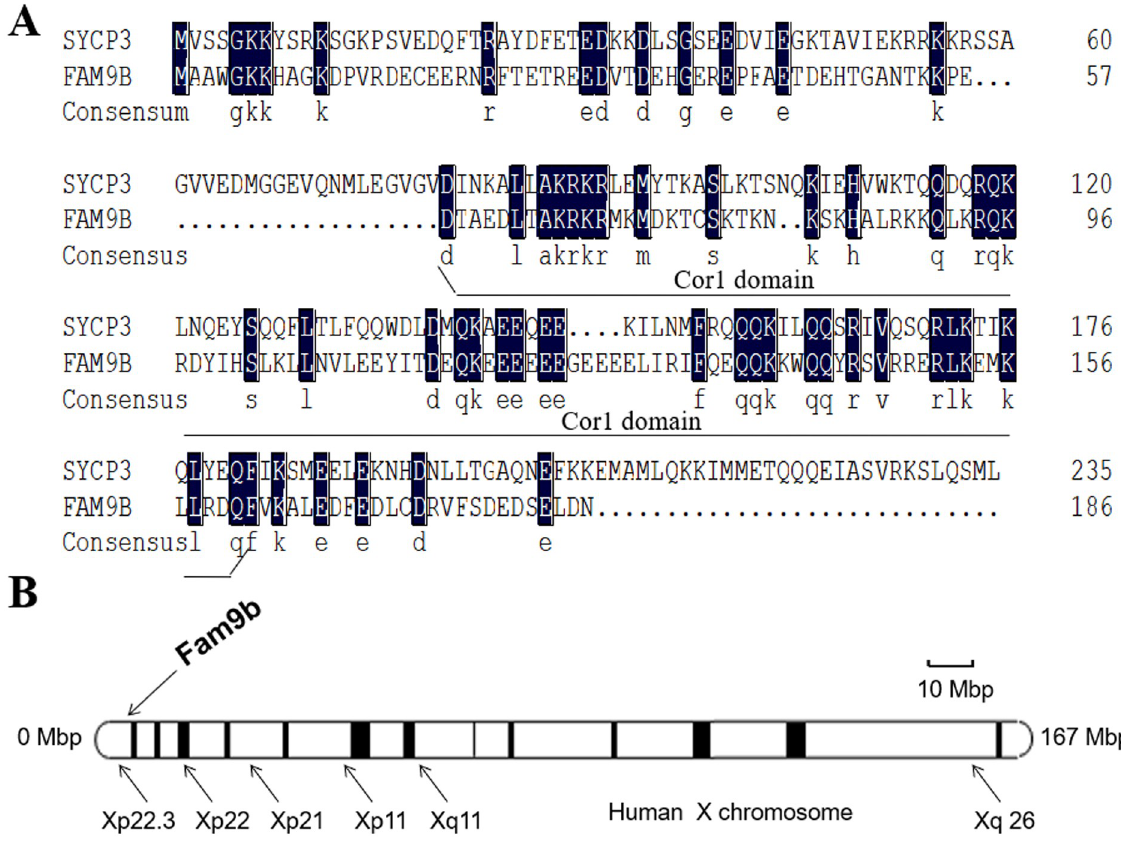
Fig 1. Fam9 mapped on human X chromosomes shares homology with SYCP3. (A) Fam9b -conserved Cor1 domain shares homology with SYCP3. (B) Fam9 mapped on Xp22.3 of human X chromosomes.